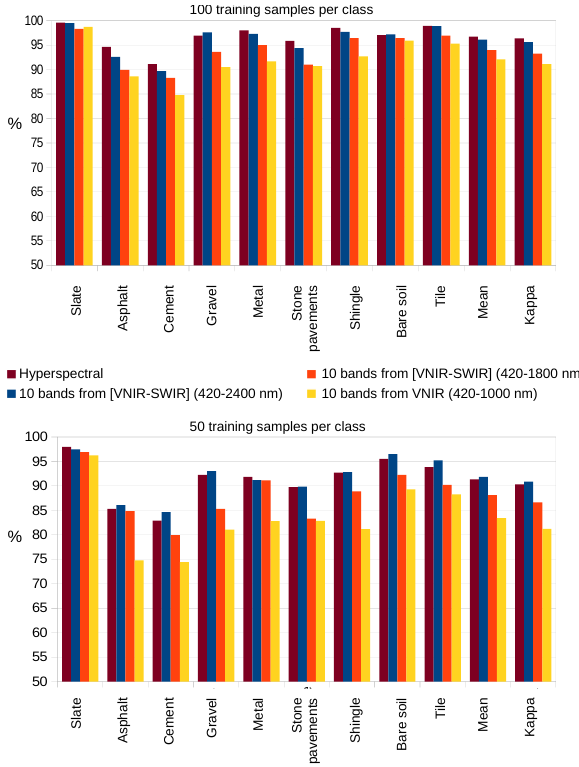
Figure 7: Quantitative results reached using selected band subsets of 10 bands from different spectral domains: F-scores of the dif- ferent classes and Kappa coefficient reached by RBF SVM clas- sification. The classifier was trained using 100 samples (top) and 50 samples (bottom).